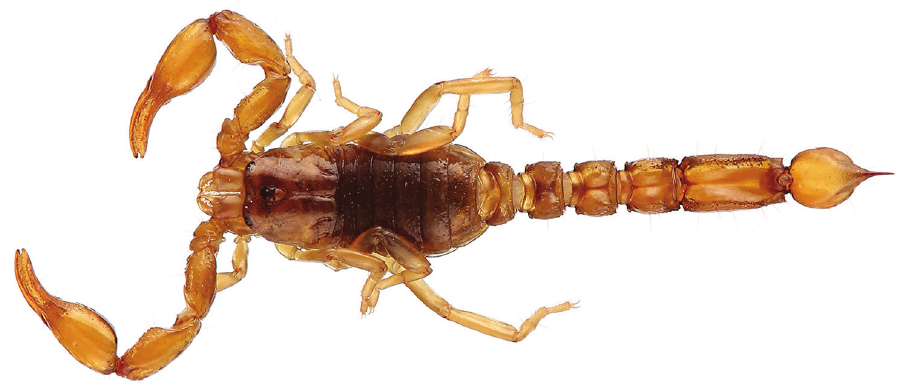
Figure 30. Spinochactas mitaraka , female holotype from Mitaraka massif (photograph MNHN / E.-A. Leguin; 2016 Elsevier Masson